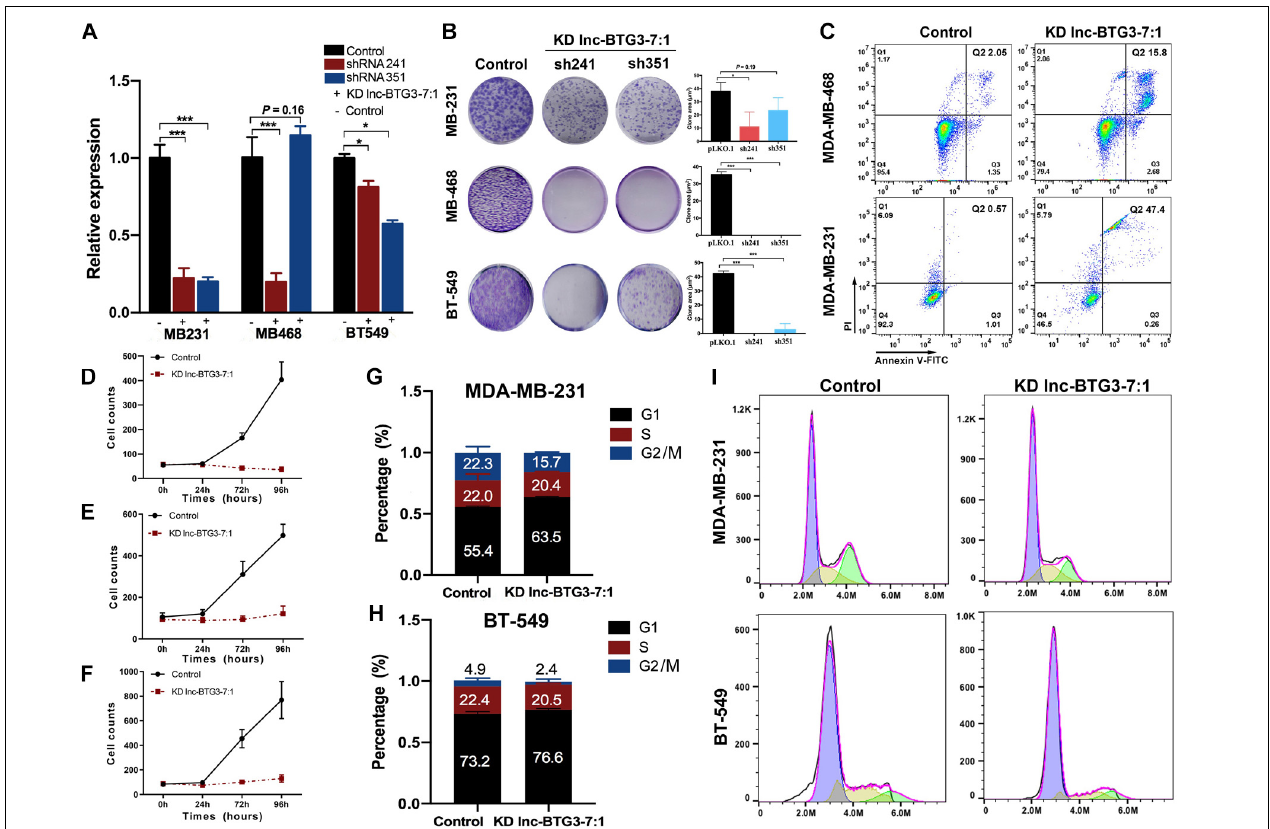
FIGURE 3 | Lnc-BTG3-7:1 participates in the process of TNBC progress. (A) The expression level of Lnc-BTG3-7:1 in three TNBC cell lines significantly decreased after Lnc-BTG3-7:1 knockdown (KD). KD efficiency of shRNA 351 was relatively poor in MDA-MB-468. (* P < 0.05, *** P < 0.005). (B) . Knockdown of Lnc-BTG3-7:1 significantly reduced colony forming capacity of the three TNBC cell lines ( P < 0.05). (C) Knockdown of Lnc-BTG3-7:1 (with shRNA241) induced early apoptosis (Q3: 2.68%) cells and late apoptosis (Q2: 15.8%) cells compared to that of the control group (Q3: 1.35%, Q2: 2.05%) in MDA-MB-468 cell, and the early apoptosis (Q3: 0.26%) cells and late apoptosis (Q2: 47.4%) cells compared with the control group (Q3: 1.01%, Q2: 0.57%) in MDA-MB-231 cells, respectively ( P < 0.05). (D–F) Short-term proliferation capacity of three TNBC cell lines was significantly inhibited in KD Lnc-BTG3-7:1group ( P < 0.05). (G–I) Cell cycle was arrested in G1 phase both in MDA-MB-231 and BT-549 in KD Lnc-BTG3-7:1 group ( P <